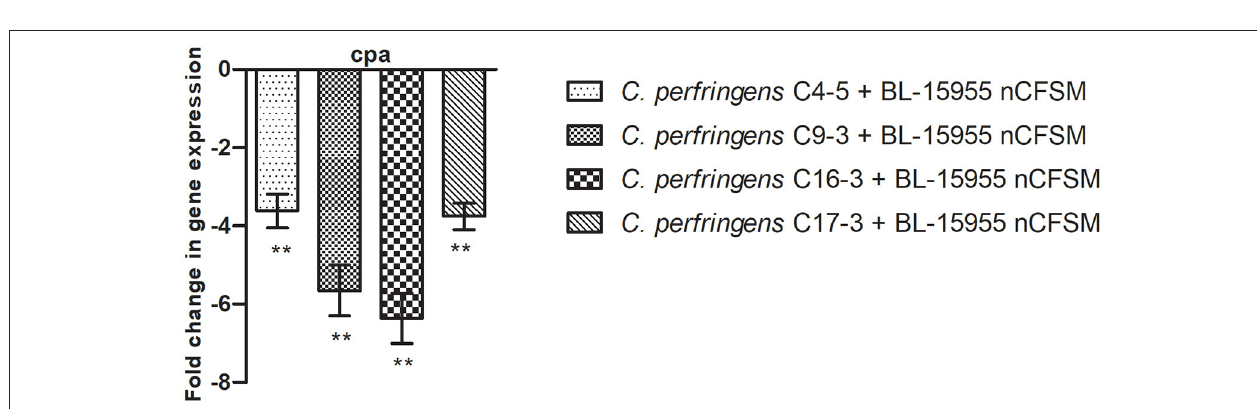
FIGURE 4 | Effect of B. longum BL-15955 nCFSM on expression of cpa in 4 C. perfringens strains presented as fold change of expression levels in nCFSM relative to non-fermented milk. The expression data were normalized to two validated reference genes, 16sRNA and GAPDH . Three independent replicates including two technical replicates each were performed. The data shown represents the mean and the error bars represent standard deviations. The stars indicate statistical significance at different levels: ** P ≤ 0.01.